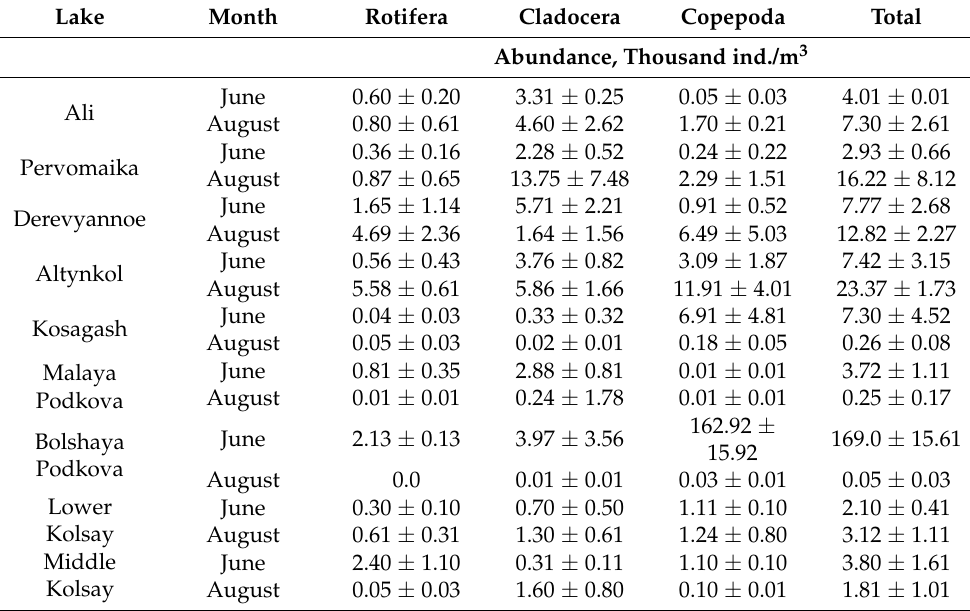
Table 7. Zooplankton abundance in small lakes of South-East Kazakhstan, mean values with standard deviation, summer 2019.